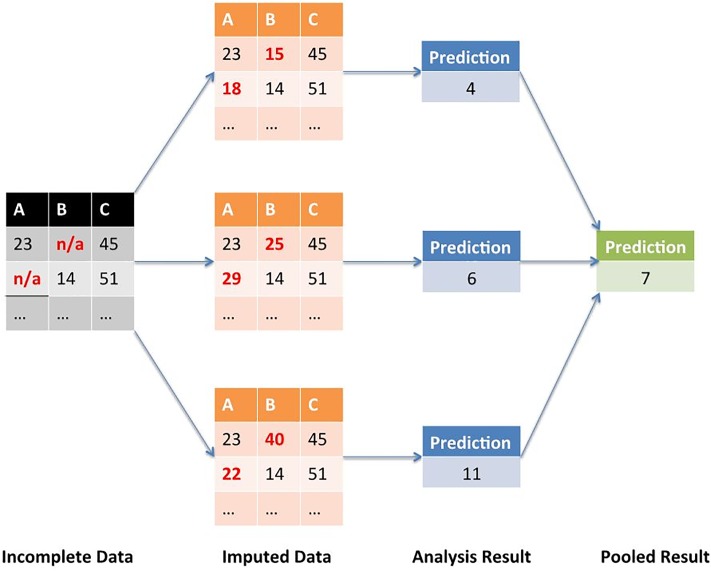
Multiple imputation.